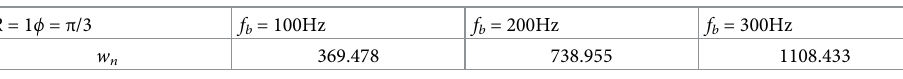
Table 1. Values of w n in different bandwidths.